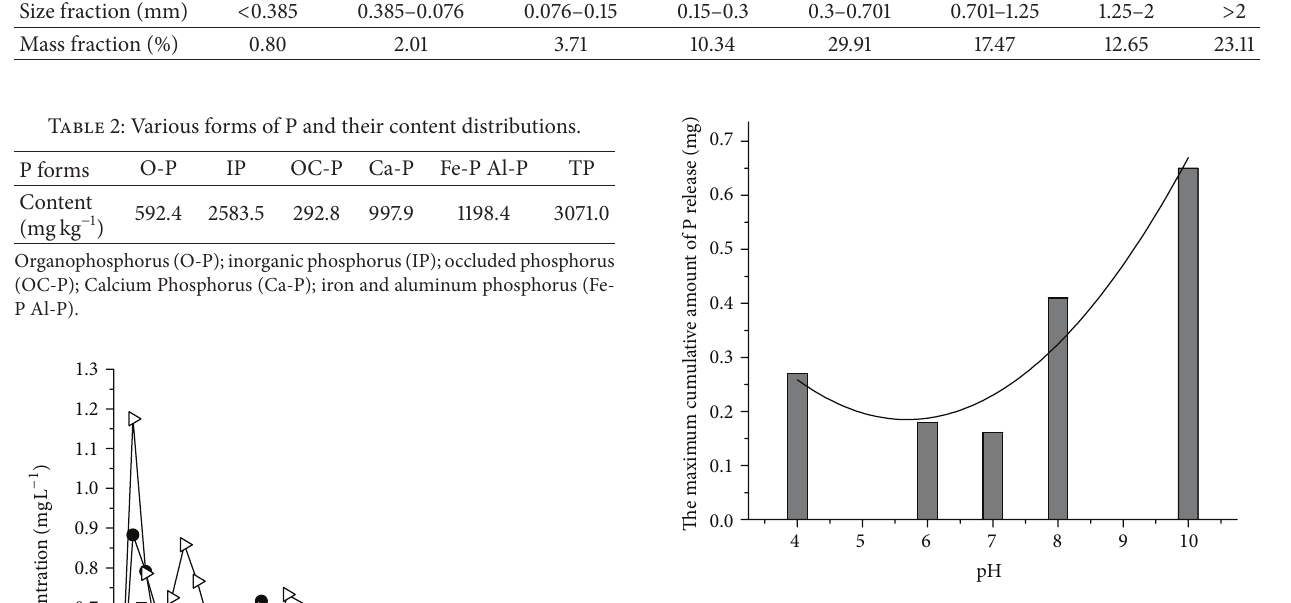
Figure 2: Maximum cumulative amount of P release as a function of